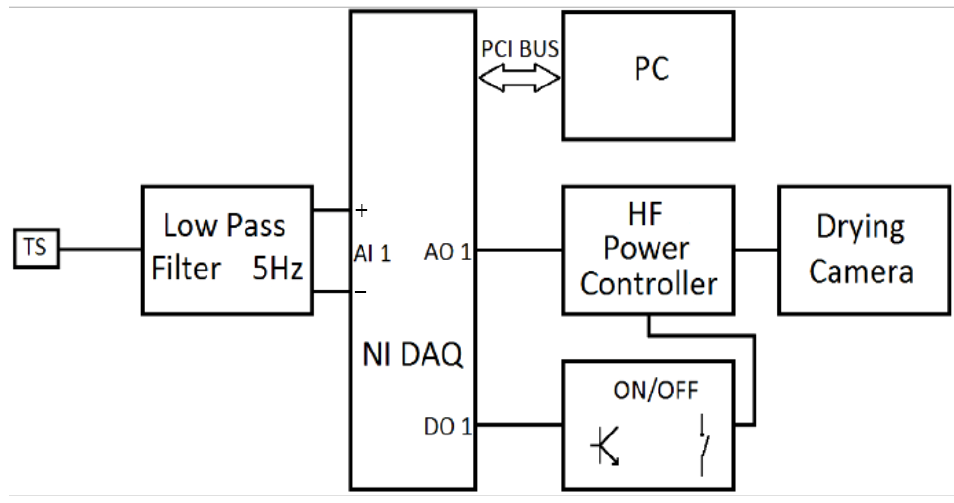
Figure 5. Block diagram of temperature regulation of wood drying system.